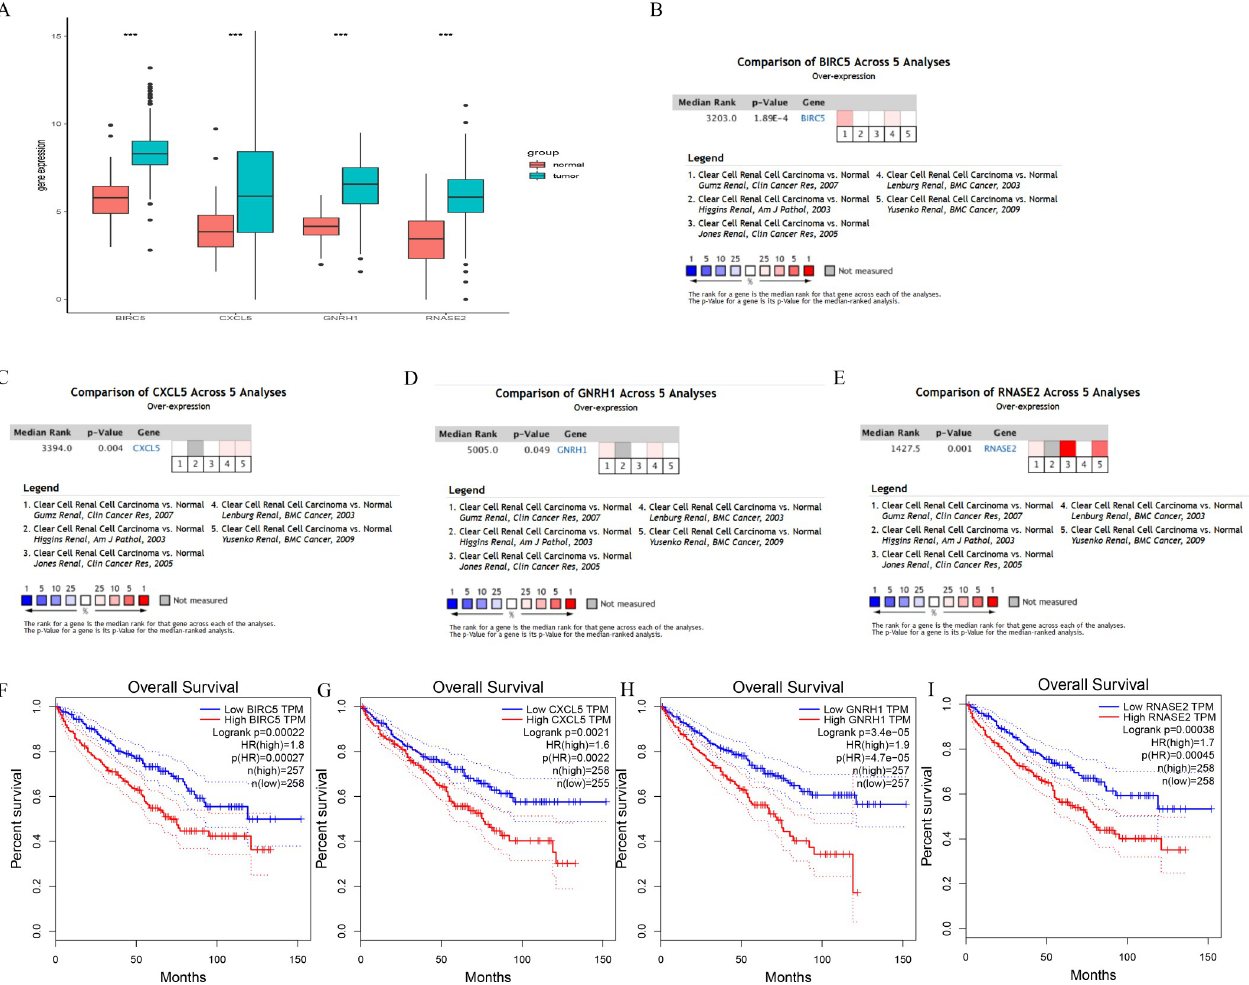
Fig 5. Differential expression and external validation of four hub genes between tumor and normal groups. (A) boxplot of the differential expression of four hub genes in TCGA. (B–E) external validation using the Oncomine database. (F–I) expression of the genes was negatively correlated to tumor prognosis ( ��� P <